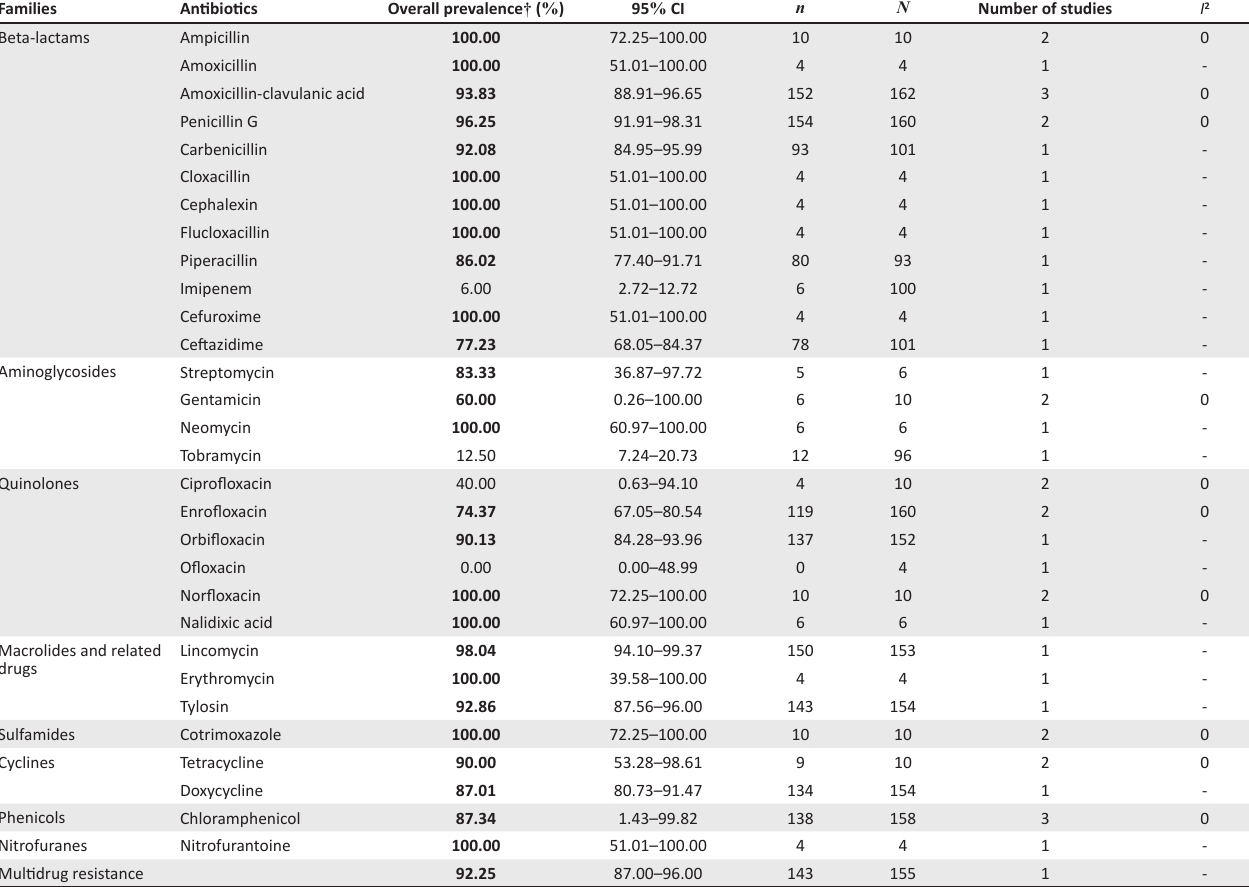
TABLE 5: Prevalence of antibiotic-resistant Pseudomonas aeruginosa strains isolated from dogs in Africa.